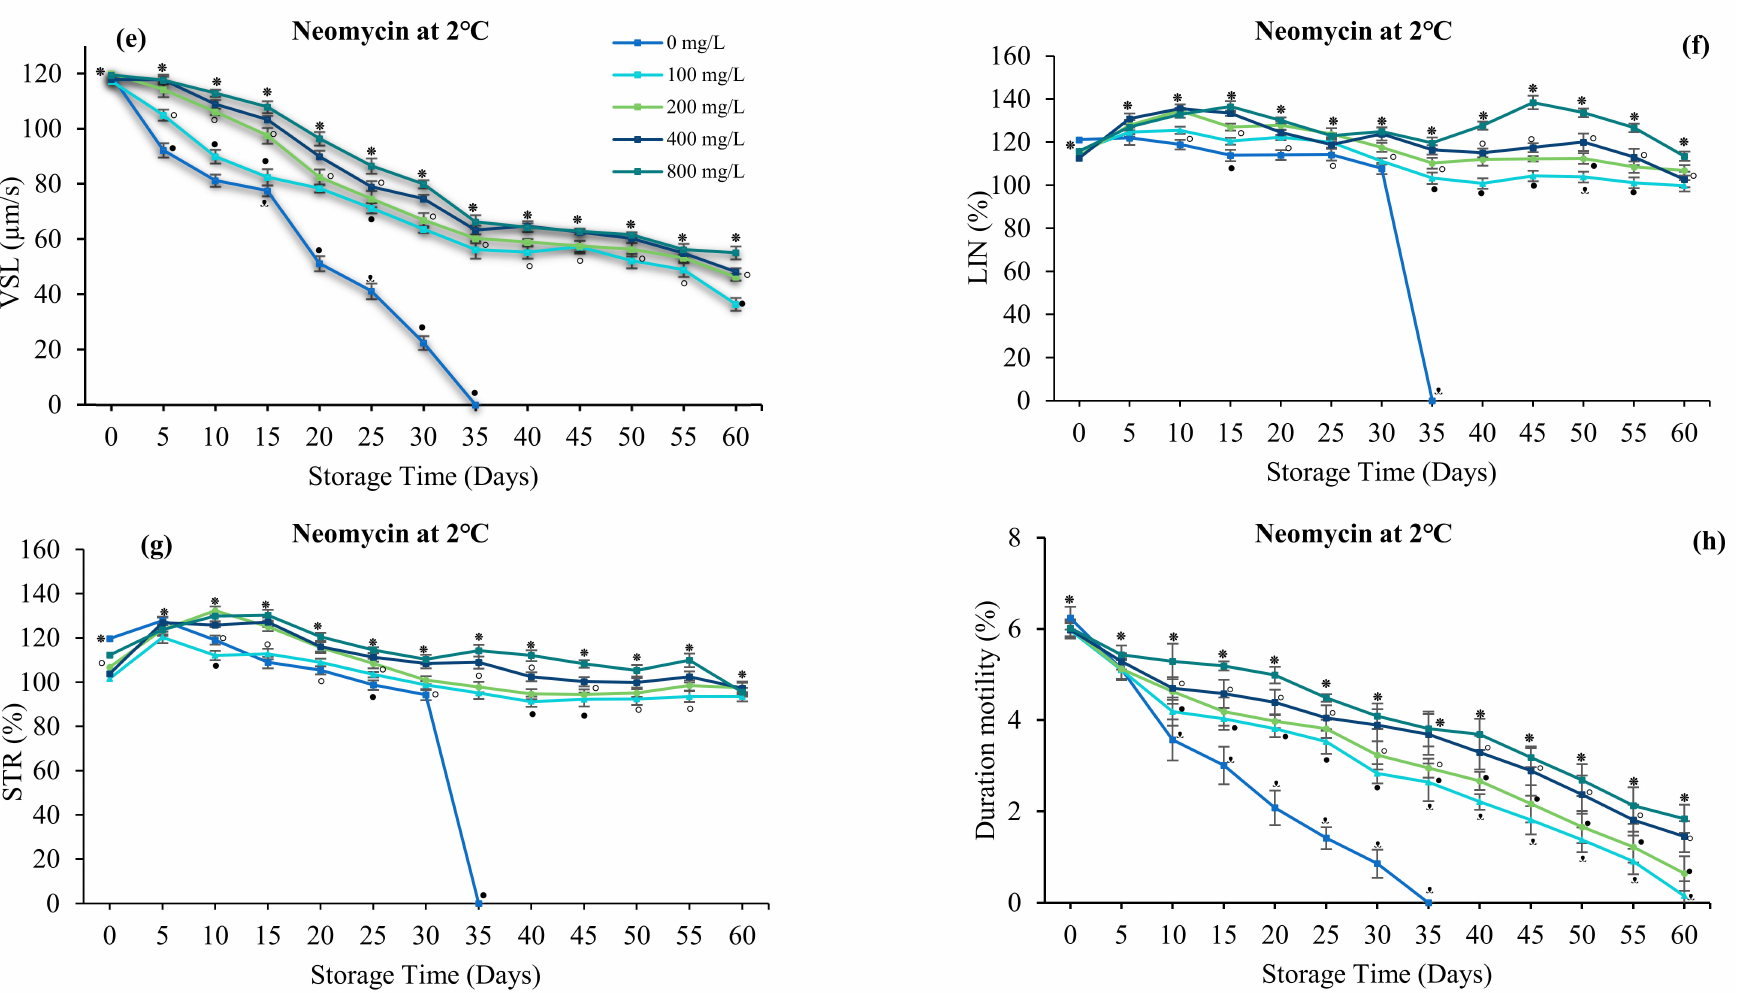
Figure 5. Effect of neomycin (N) on the sperm of spotted halibut (Verasper variegatus) stored in Stein’s solution for 60 days at 2 ◦ C. ( a ) Motility (%), ( b ) viability (%), Figure 4. Effect of gentamicin (G) on the sperm of spotted halibut ( Verasper variegatus ) stored in Stein’s solution for 60 days at 2 °C. ( a ) Motility (%), ( b ) viability Figure 4. Effect of gentamicin (G) on the sperm of spotted halibut ( Verasper variegatus ) stored in Stein’s solution for 60 days at 2 °C. ( a ) Motility (%), ( b ) viability Figure 4. Effect of gentamicin (G) on the sperm of spotted halibut ( Verasper variegatus ) stored in Stein’s solution for 60 days at 2 °C. ( a ) Motility (%), ( b ) viability Figure 4. Effect of gentamicin (G) on the sperm of spotted halibut ( Verasper variegatus ) stored in Stein’s solution for 60 days at 2 °C. ( a ) Motility (%), ( b ) viability ( c ) average path velocity (VAP; µ m/s), ( d ) curvilinear line velocity (VCL; µ m/s), ( e ) straight-line velocity (VSL; µ m/s), ( f ) linearity (LIN; %), ( g ) straightness (STR; (%), ( c ) average path velocity (VAP; µm/s), ( d ) curvilinear line velocity (VCL; µm/s), ( e ) straight-line velocity (VSL; µm/s), ( f ) linearity (LIN; %), ( g ) straightness (%), ( c ) average path velocity (VAP; µm/s), ( d ) curvilinear line velocity (VCL; µm/s), ( e ) straight-line velocity (VSL; µm/s), ( f ) linearity (LIN; %), ( g ) straightness (%), ( c ) average path velocity (VAP; µm/s), ( d ) curvilinear line velocity (VCL; µm/s), ( e ) straight-line velocity (VSL; µm/s), ( f ) linearity (LIN; %), ( g ) straightness (%), ( c ) average path velocity (VAP; µm/s), ( d ) curvilinear line velocity (VCL; µm/s), ( e ) straight-line velocity (VSL; µm/s), ( f ) linearity (LIN; %), ( g ) straightness %), and ( h ) duration motility (minutes). Symbols ( (STR; %), and ( h ) duration motility (minutes). Symbols ( ⁕ , ⸰ , • , ᵜ , ▪ ) indicate significant differences ( p < 0.05). (STR; %), and ( h ) duration motility (minutes). Symbols ( ⁕ , ⸰ , • , ᵜ , ▪ ) indicate significant differences ( p < 0.05). (STR; %), and ( h ) duration motility (minutes). Symbols ( ⁕ , ⸰ , • , ᵜ , ▪ ) indicate significant differences ( p < 0.05). (STR; %), and ( h ) duration motility (minutes). Symbols ( ⁕ , ⸰ , • , ᵜ , ▪ ) indicate significant differences ( p <